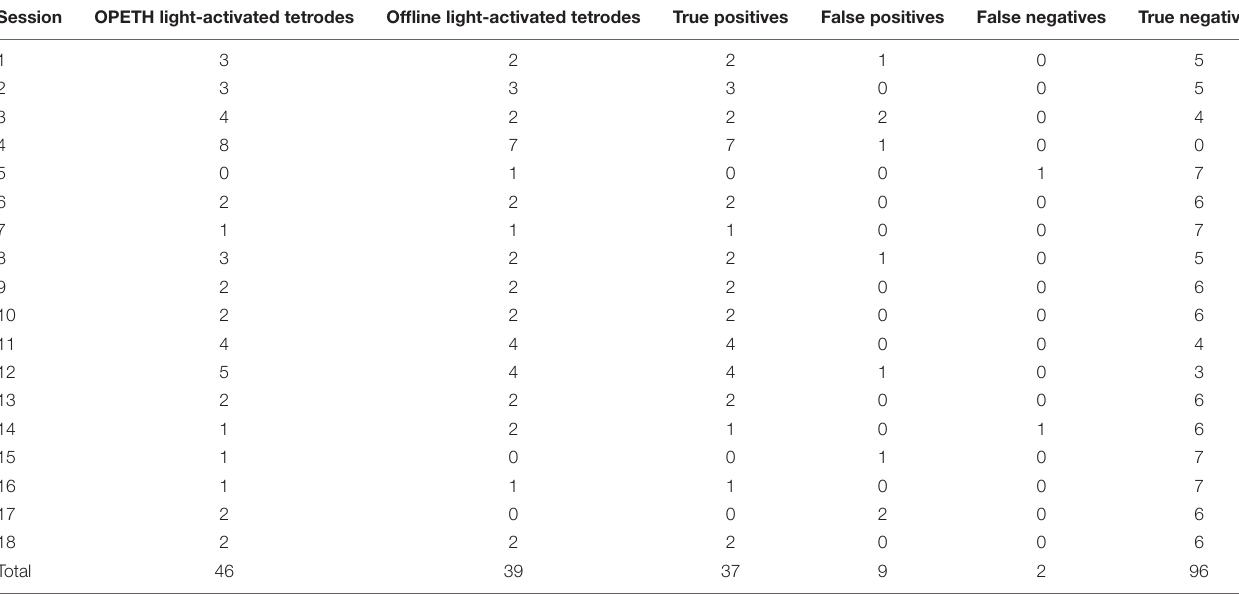
TABLE 3 | Matching between online and offline detection of light-evoked activity. Session OPETH light-activated tetrodes Offline light-activated tetrodes True